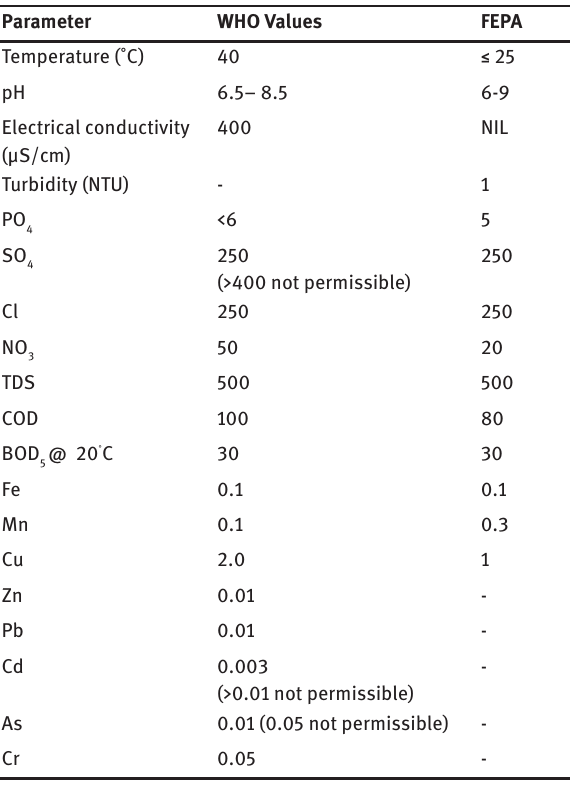
Table 2: Guidelines for drinking water quality by WHO and FEPA. Parameter